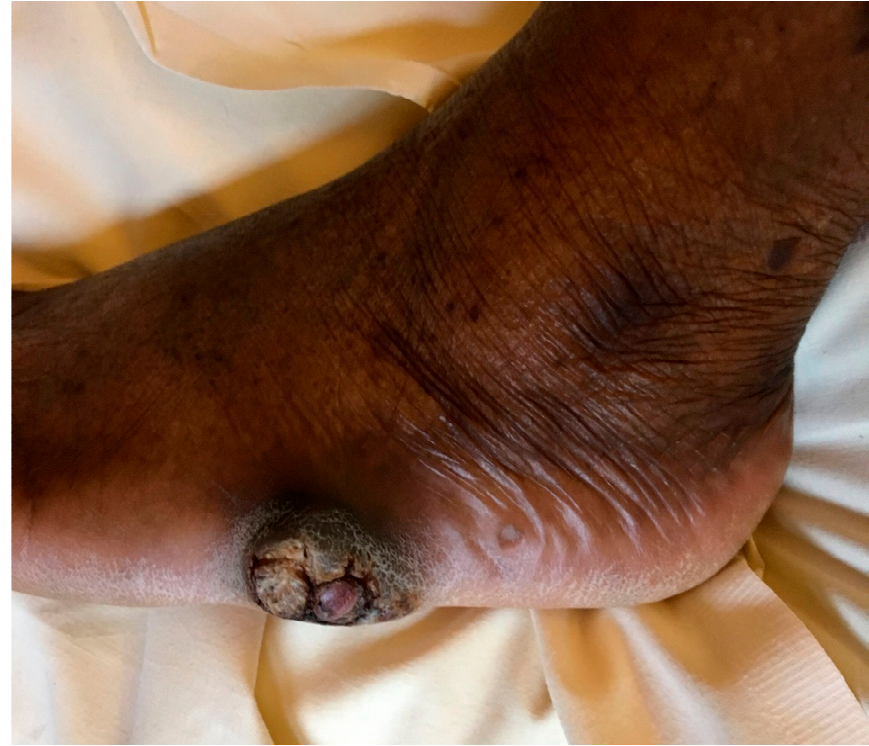
Figure 1. Nodular and warty foot lesion showing pseudoepitheliomatous hyperplasia and hyperkeratosis, after five months of progression.